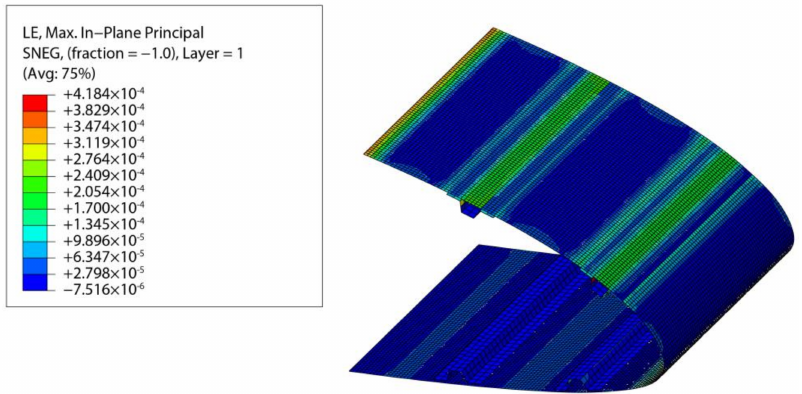
Figure 23. Strain contour of the compliant skin in cruising